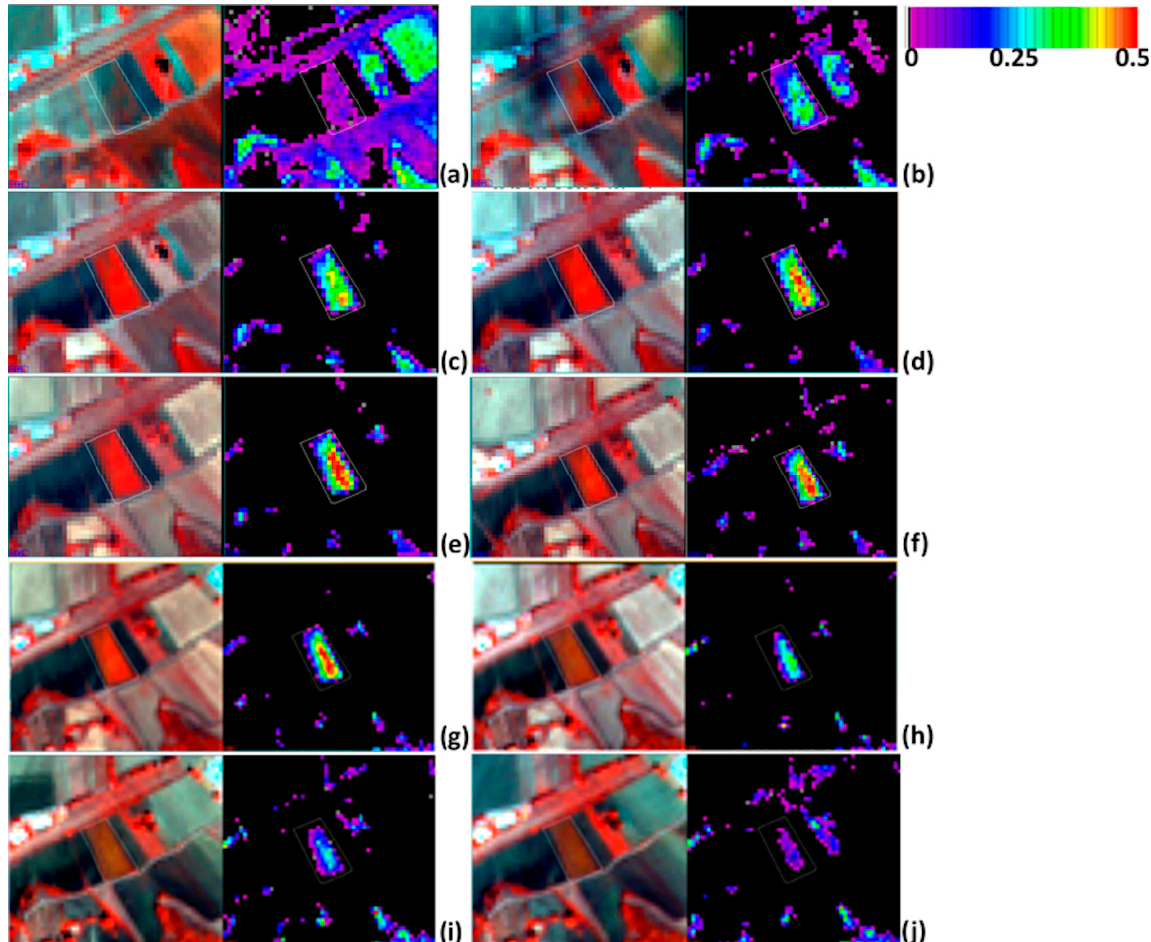
Figure 8. S2 multispectral satellite images zoom on the hemp crop fields acquired on the study area from June to October 2017: ( a ) 14 June; ( b ) 27 June; ( c ) 7 July; ( d ) 27 July; ( e ) 6 August; ( f ) 16 August. ( g ) 23 August. ( h ) 5 September; ( i ) 15 September; ( j ) 22 September. For each zoom imagery, the left image shows the S2 RGB (R: 842 nm; G: 560 nm; B: 490 nm), while right image depicts the corresponding classified imagery (with a GRVI range of values between 0 and 0.5 and the relative colour legend).